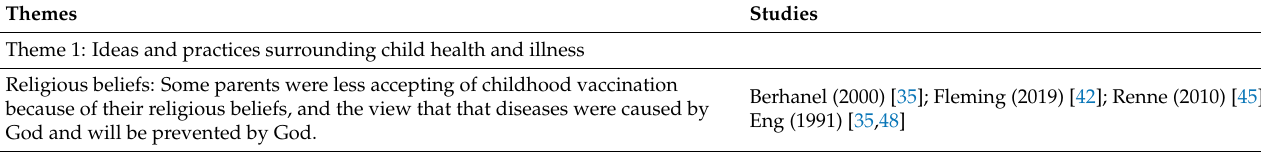
Table A2. Summary of the review